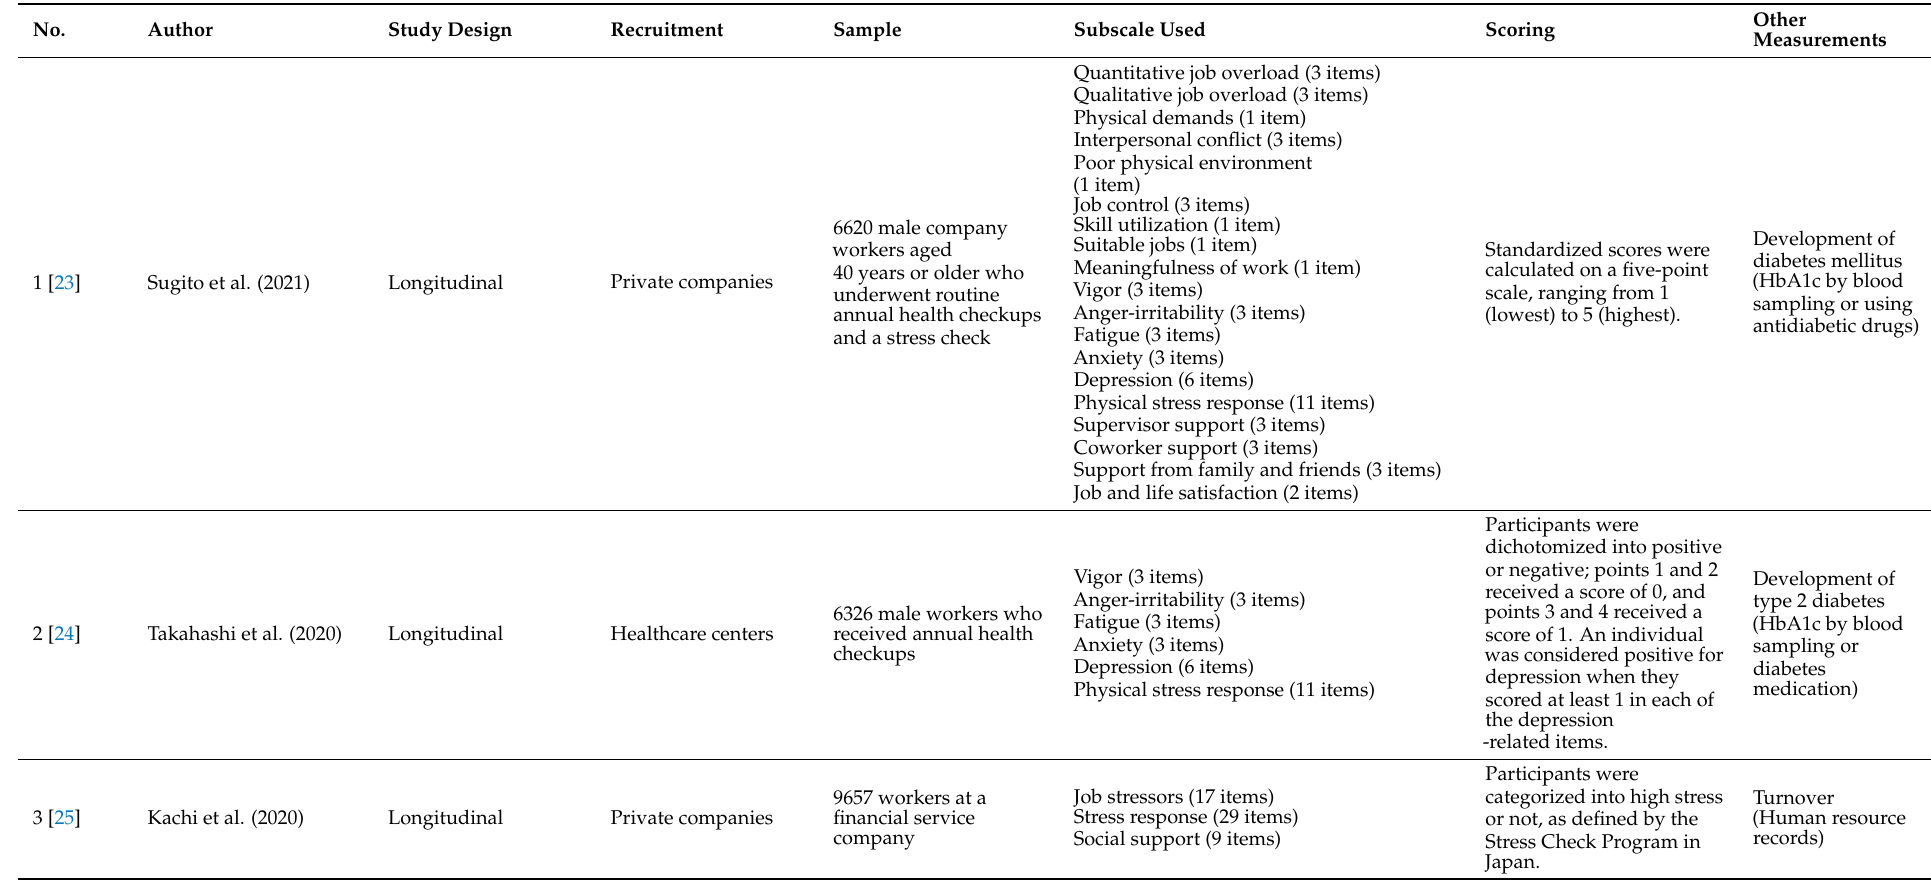
Table A1. Summary of the included studies that used the Brief Job Stress